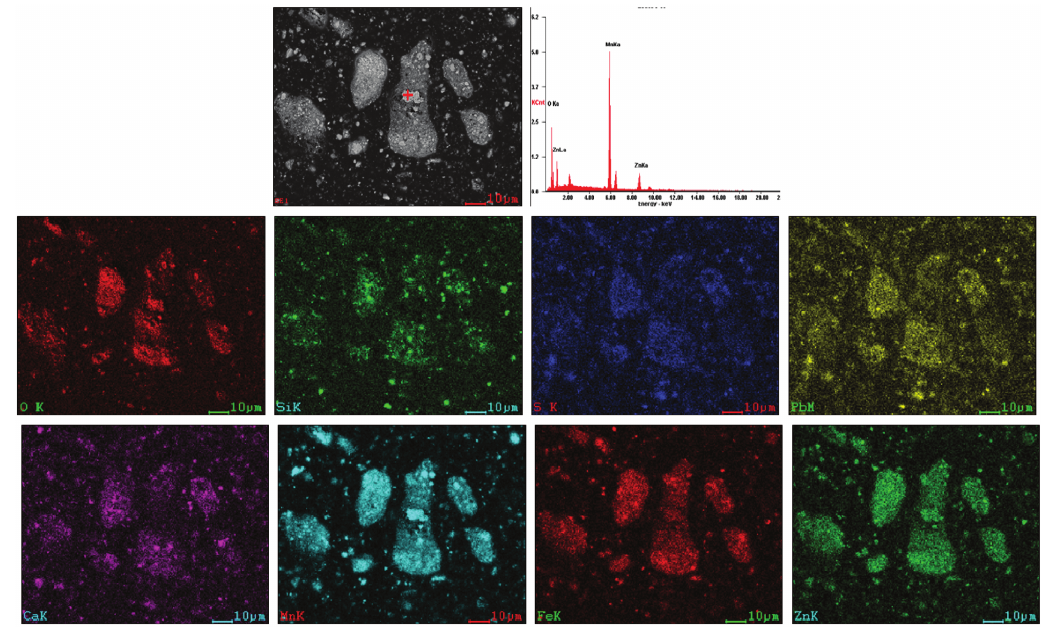
Figure 6: SEM-EDAX analysis of zinc calcine (No.